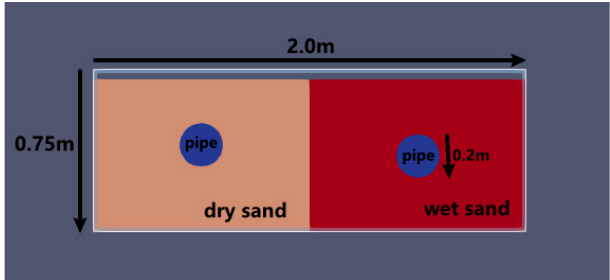
Figure 6. Schematic diagram of the forward model for GPR FDTD simulation.